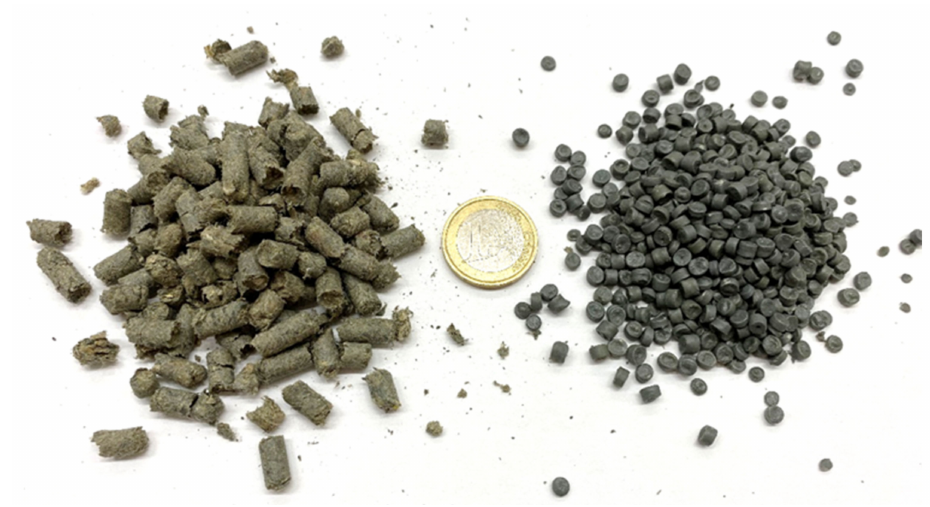
Figure 4. The cellulose-synthetic fiber containing plastomeric polymers vs. plastomeric polymer compound. The scale coin is EUR 1; 23.25 mm. Table 3. Some of the properties of the